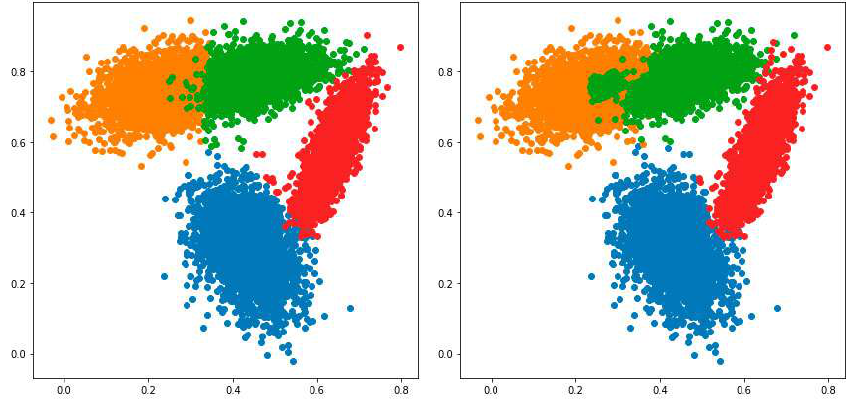
Figure 10. Example of instances from the DS 9 , classified by HPFuzzNDA (the left graph) and PFuzzND (the right graph)